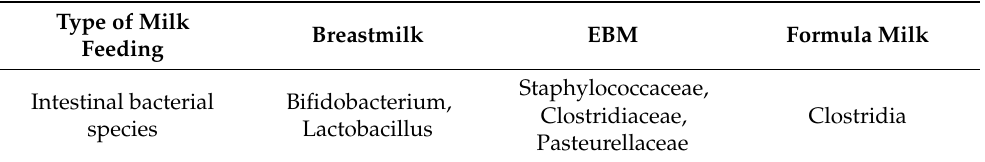
Table 1. Most typically represented intestinal bacterial species based on the type of feeding. Expressed breast milk: